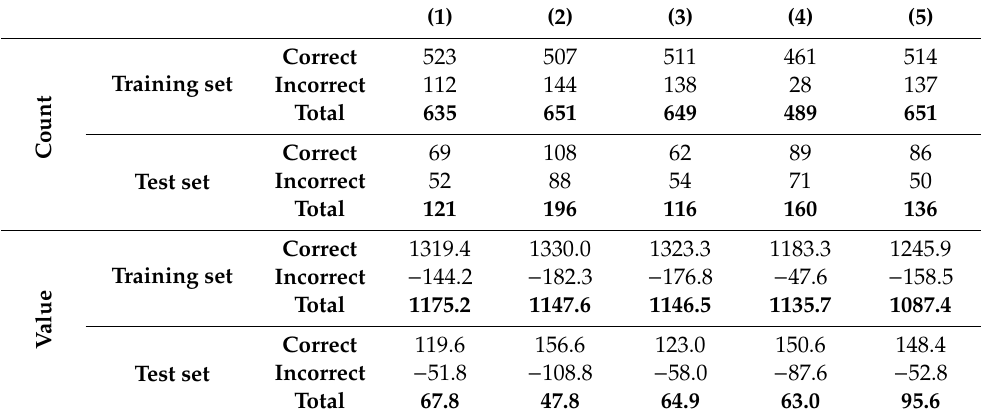
Table 8. Results obtained by the top 5 SANNs in the training